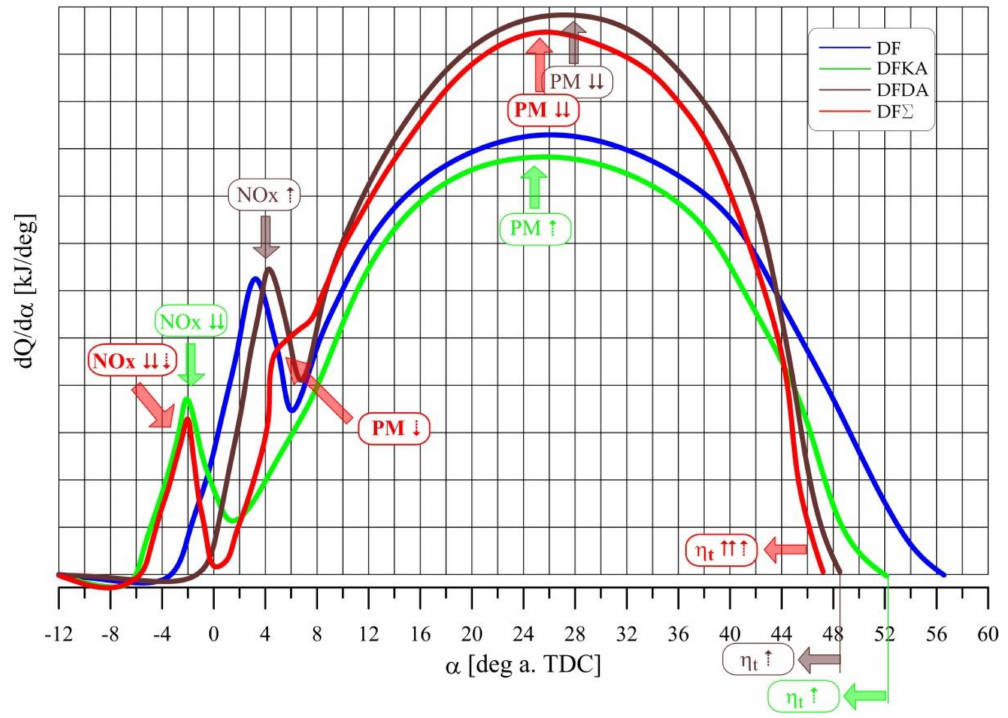
Figure 29. Rate of heat release in the cylinder of a diesel engine for all tested